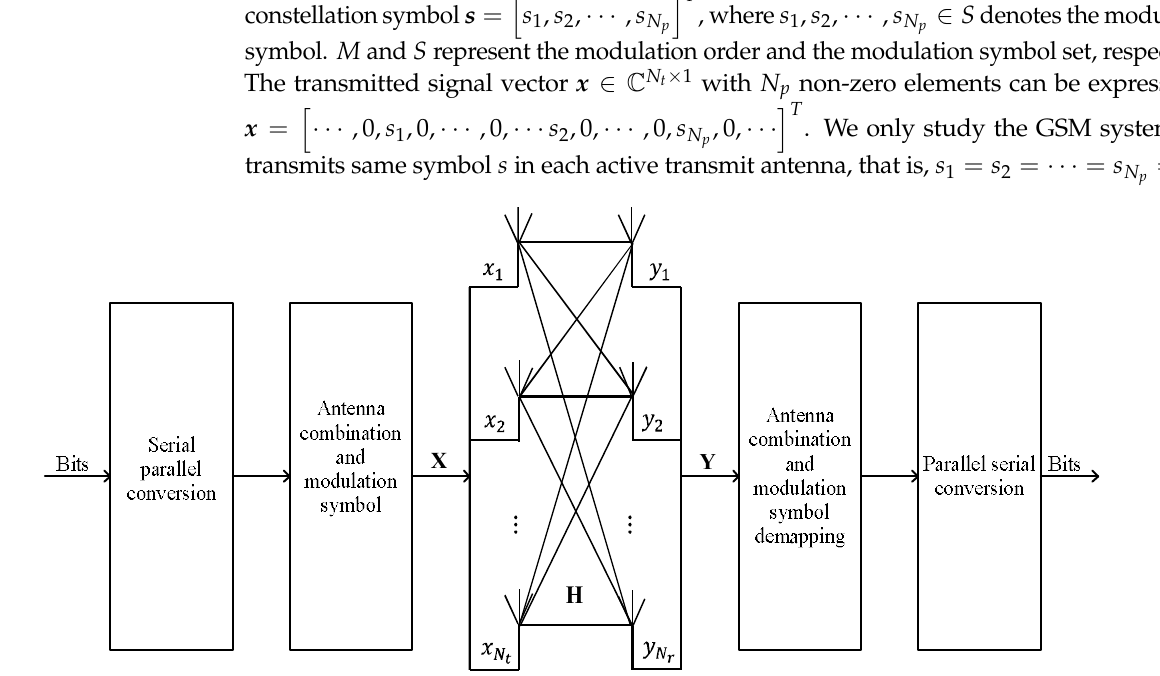
N transmit antennas and N receive anten- Figure 1. The block diagram of GSM system with Figure 1. The block diagram of GSM system with N t transmit antennas and N r receive antennas. t r nas. It is assumed that the i -th TACs is used to transmit modulation symbols under the condition that the channel is Rayleigh fading channel and the channel gain is constant within a symbol period. Then the received signal vector y ∈ C N r × 1 can be expressed